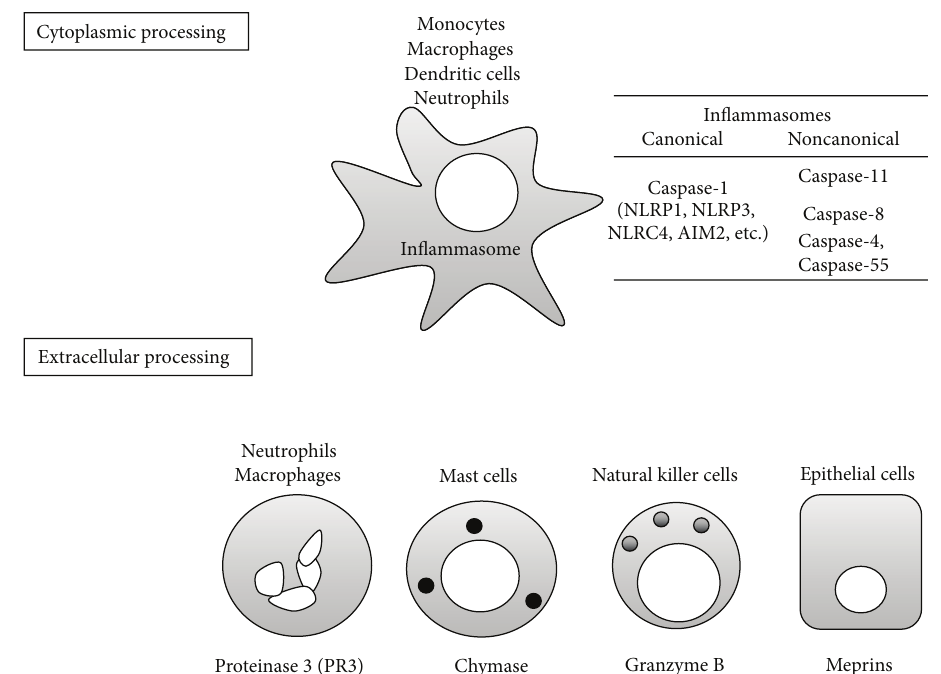
Figure 3: Processing enzymes dependent on and independent of the inflammasome. Caspase-1 is an enzyme that putatively converts IL-1 𝛽 andIL-18.Caspase-1isproducedaszymogenandrequirescleavage.Inflammasomesarethemachineryinwhichcaspase-1,IL-1 𝛽 ,andIL-18are processed. Inflammasomes are classified as canonical and noncanonical. Canonical inflammasomes can be divided into 4 main types based on differences in cytoplasmic PRRs, such as NLRP1, NLRP3, NLRC4, and AIM. Noncanonical inflammasomes activate caspase-11, caspase-8, caspase-4, and caspase-5 and often collaborate with the canonical inflammasomes. Monocyte-macrophage lineage cells, dendritic cells, and neutrophils can harbor inflammasomes. Various enzymes have the capacity to process IL-1 𝛽 and IL-18 extracellularly. Neutrophil-derived proteinase 3, mast cell chymase, granzyme B produced by NK cells, and meprins produced by epithelial cells can convert pro-IL-1 𝛽 and pro-IL-18 into mature ligands. AIM: absent in melanoma 2; NK: natural killer; NLRC: NACHT, leucine-rich repeat, and caspase recruitment domain-containing protein; NLRP: NACHT, leucine-rich repeat, and pyrin domain-containing protein; PRR: pattern recognition receptor.